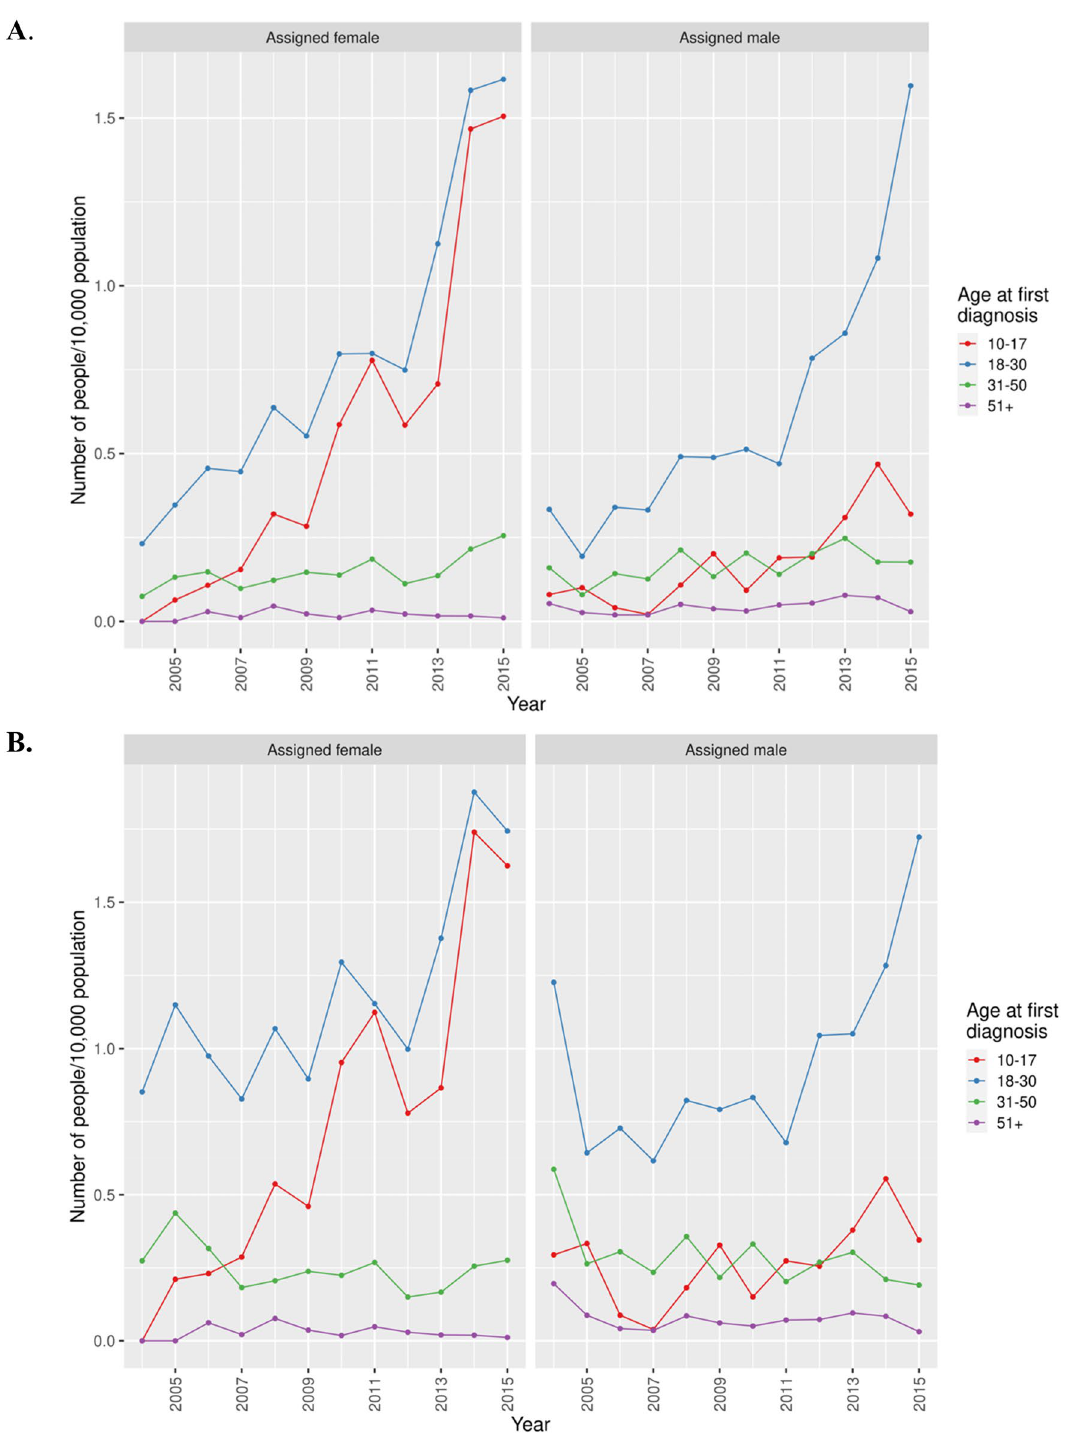
Figure 4. Crude ( A ) and coverage-adjusted ( B ) incidence rates of GD, defined by ≥ 4 diagnoses, in Sweden 2004–2015, stratified by birth assigned sex and